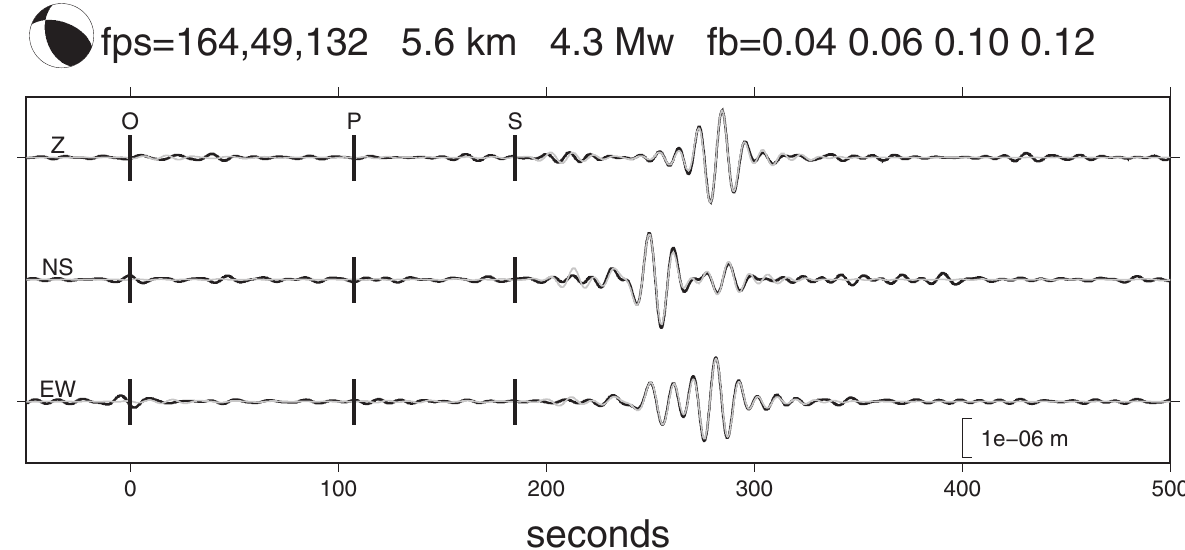
Figure 5 - Coxim event surface waves modeling using ISOLA program with CPSP methodology from Fojtíková and Zahradník (2014). In order, we have Z, NS and EW components in displacement (m) from BEB4B station (~ 800 km distance) with origin time (O), P and S-waves arrival marked. Observed data is the black line and synthetic is gray. The focal mechanism is shown in the top left with the depth, magnitude Mw and the frequency band